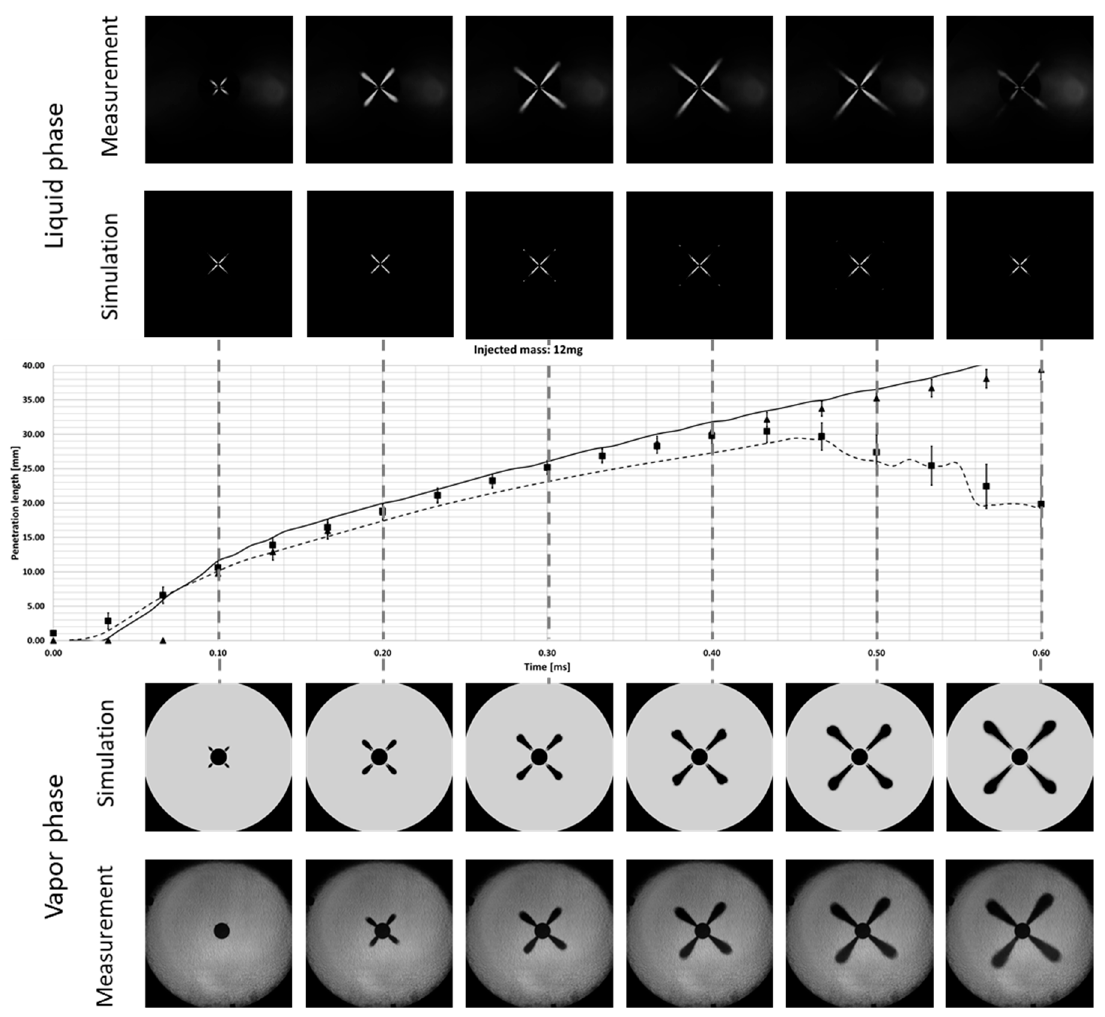
Figure 2. Visual comparison of simulation and measurement of a 12 mg diesel mass. Figure 12. Visual comparison of simulation and measurement of a 12 mg diesel